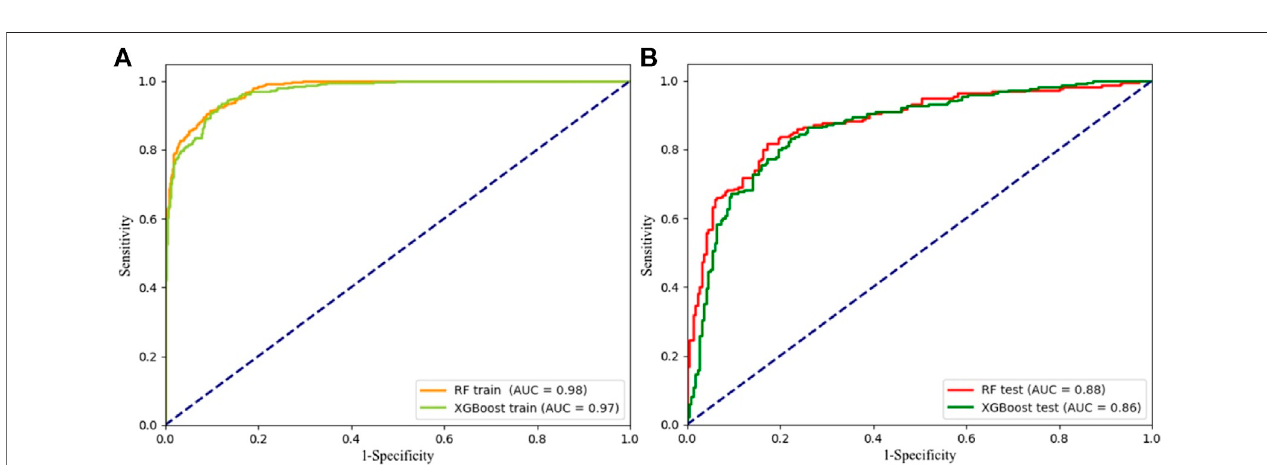
FIGURE 8 | ROC curves of the RF and the XGBoost models. (A) the training data, (B) the validating data.